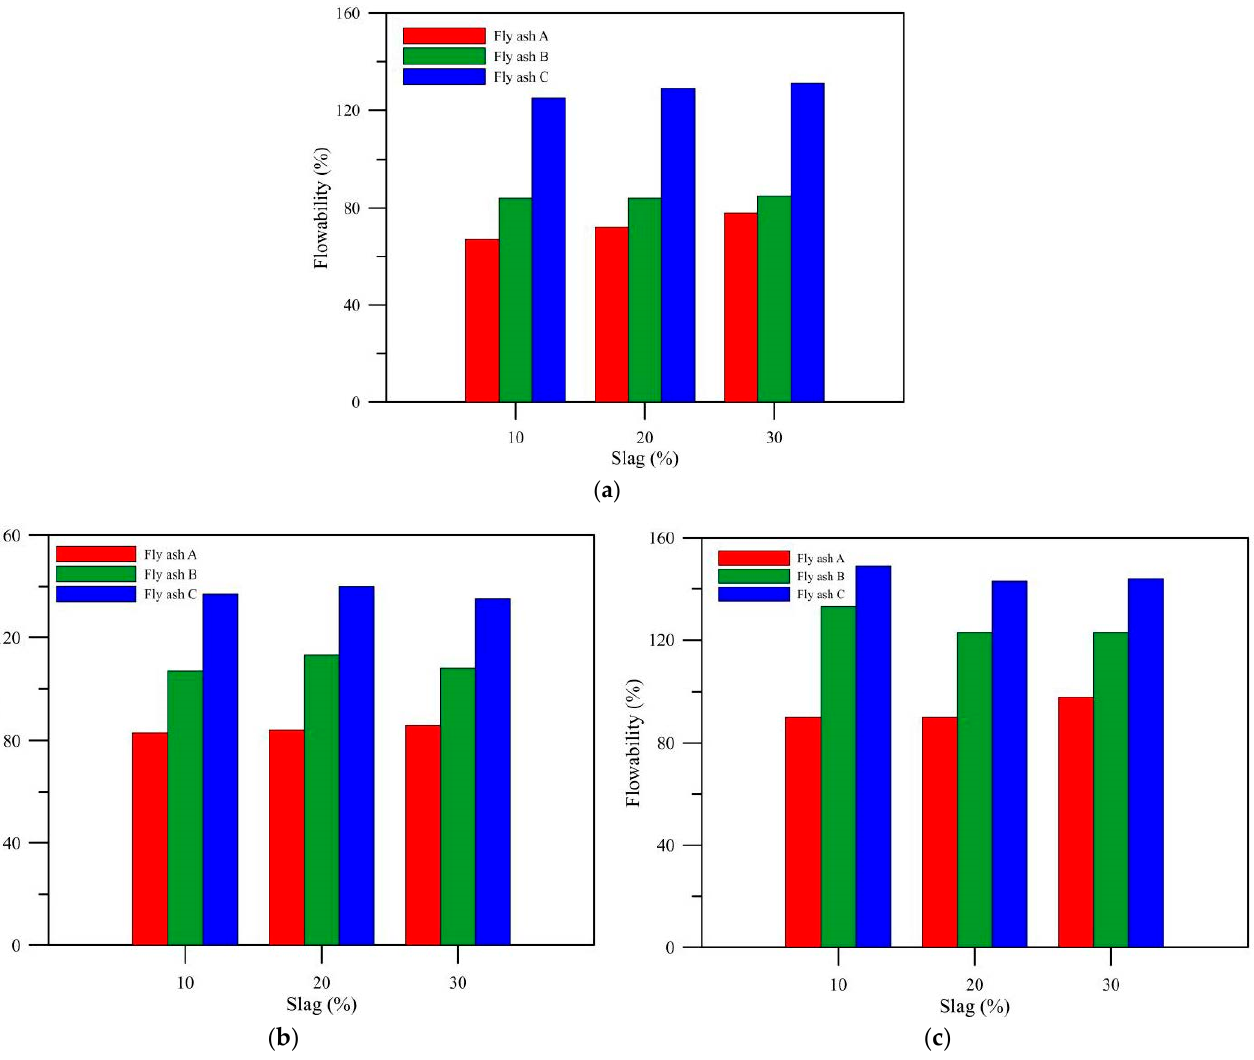
Figure 3. Flowability between different alkali-equivalents and different GGBFs replacements. ( a ) AE% = 3%; ( b ) AE% = 5%; ( c ) AE% = 8%.